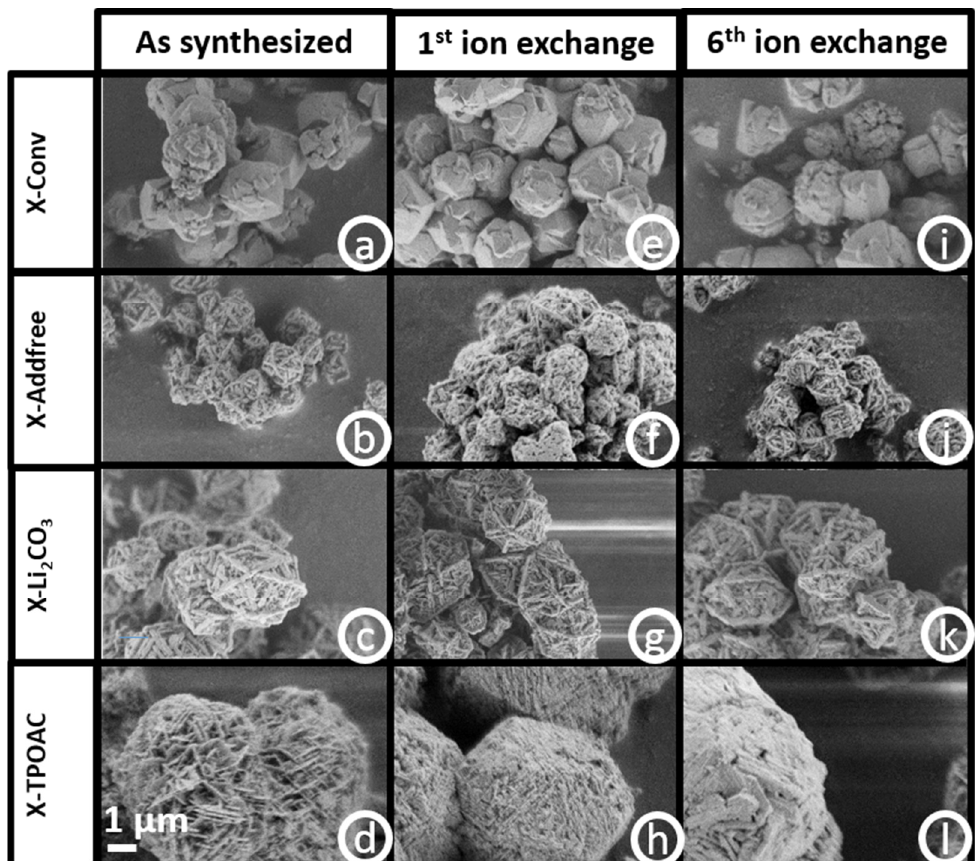
Figure 2. SEM images of zeolite samples with different morphology ( a – d ) before (as-synthesised, NaX-forms) and ( e – h ) after the first (Na/K-mixed forms) and ( i – l ) sixth ion exchange (mainly KX-forms) as indicated by the column headings.